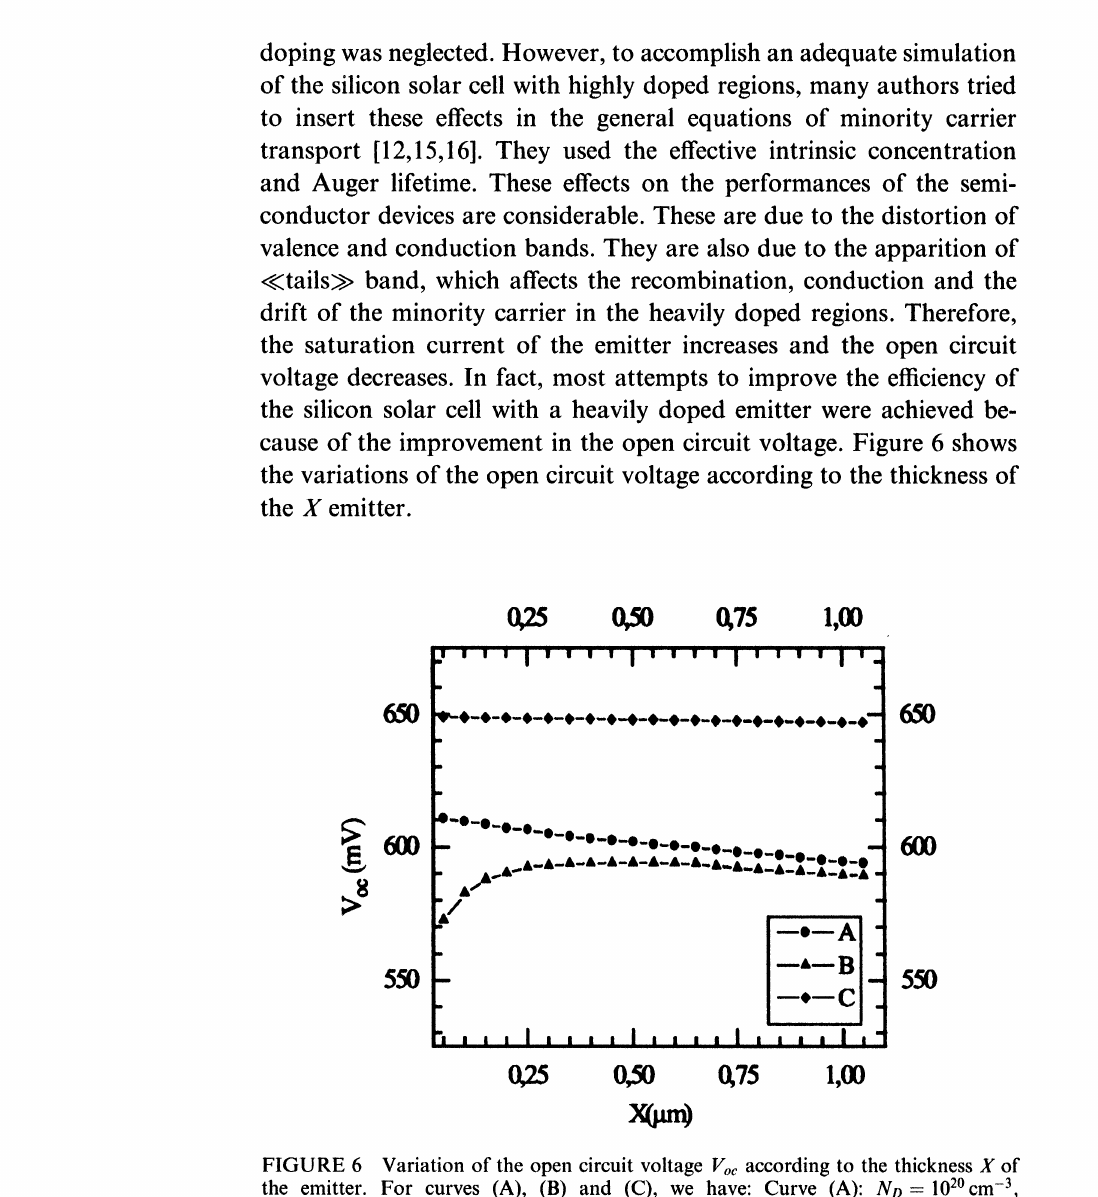
- - - S= 106cms Curve Sf--i02cms